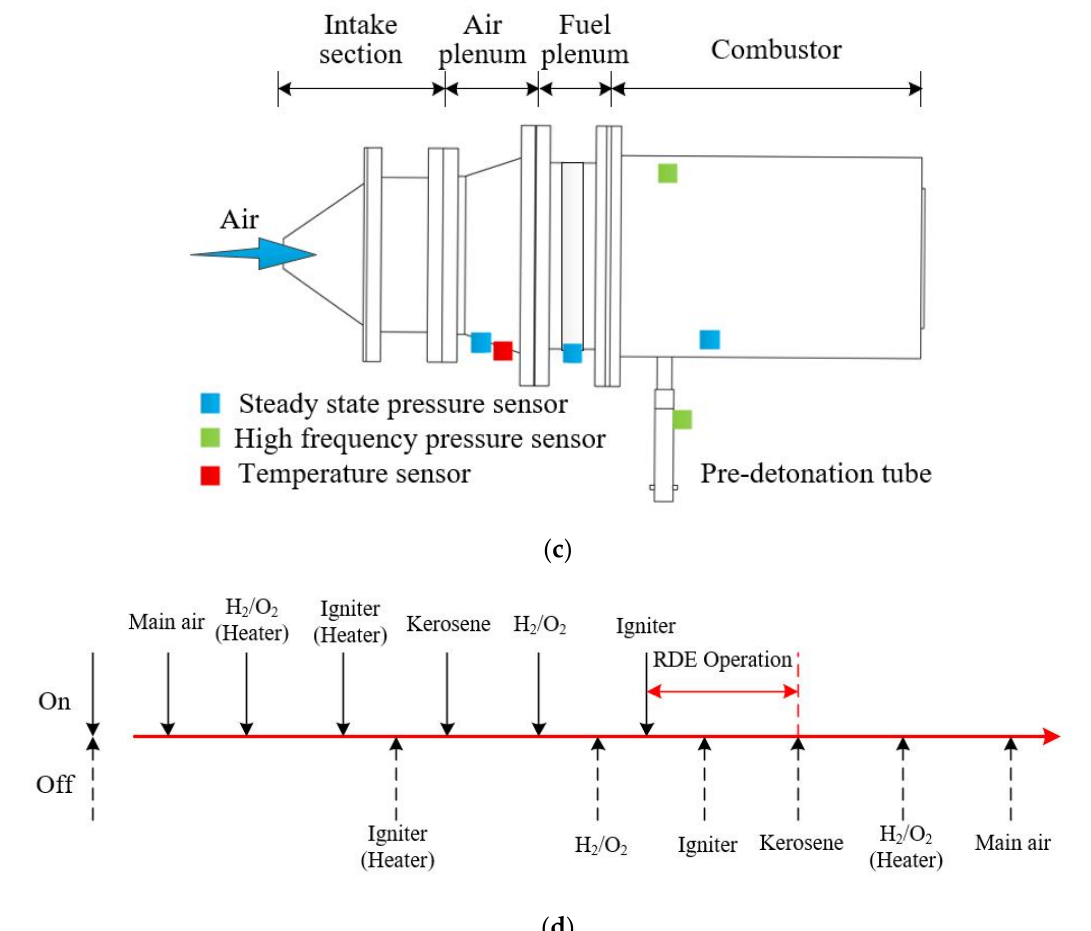
Figure 1. Overview map of experiments. ( a ) Schematic of the experimental system. ( b ) Injection scheme for kerosene. ( c ) Installation positions of sensors. ( d ) Time sequence of the experiments. Table 1. RDE hardware